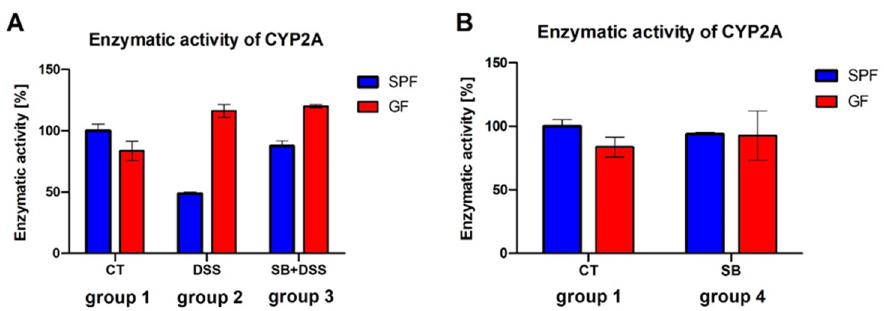
Figure 2. Enzyme activity of CYP2A in the murine liver of SPF and GF mice. Comparison of CYP2A activity of control mice to ( A ) experimental groups with DSS-induced colitis and ( B ) experimental groups treated by SB. Samples were measured in triplicate in a pooled liver microsomal fraction from 5 animals using an HPLC system with UV or fluorescence detection. Data represent the mean ± SD. CT (group 1): drinking water for 1 week; DSS (group 2): 1 week 2.5% DSS in drinking water; SB + DSS (group 3): 0.5% SB in drinking water for 2 weeks followed by a week of 2.5% DSS in drinking water; SB (group 4): 0.5% SB in drinking water for 2 weeks.